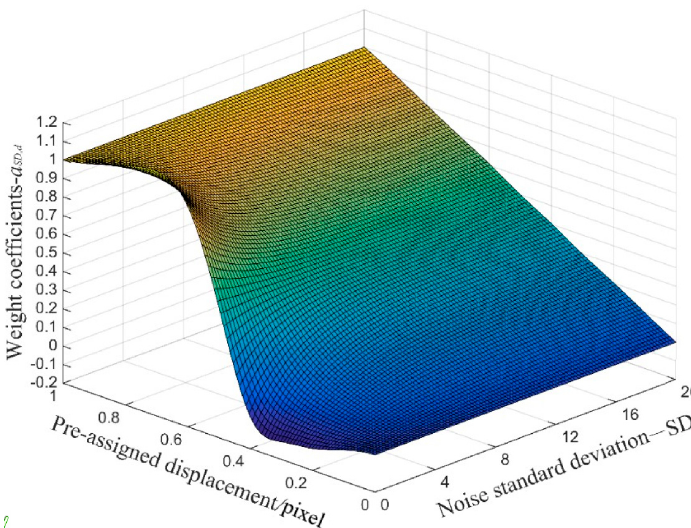
Figure 7. The curved surface of weight coefficient a SD,d .